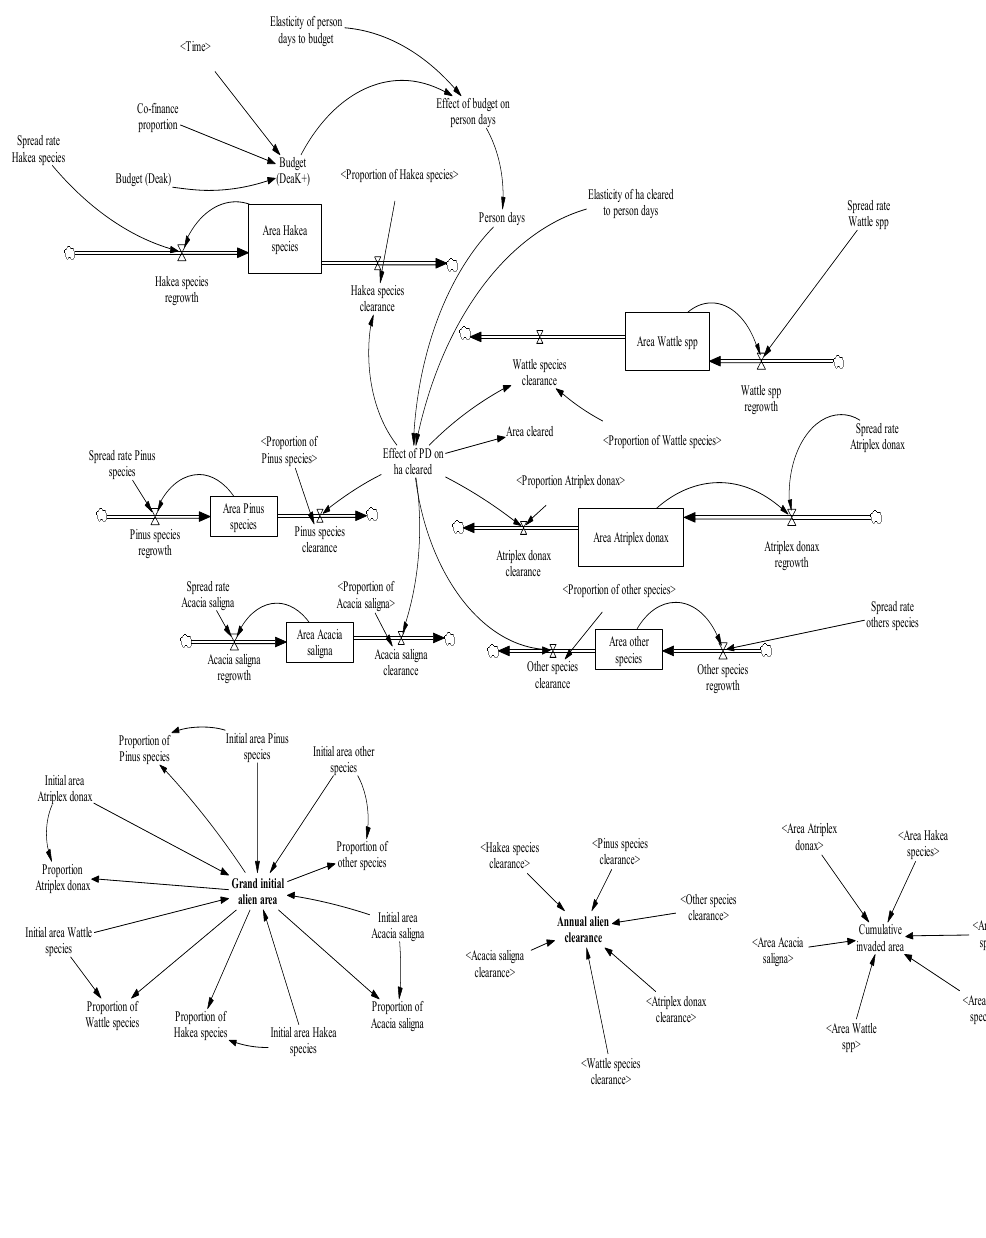
Land use sub-model for the Kouga-Krom study